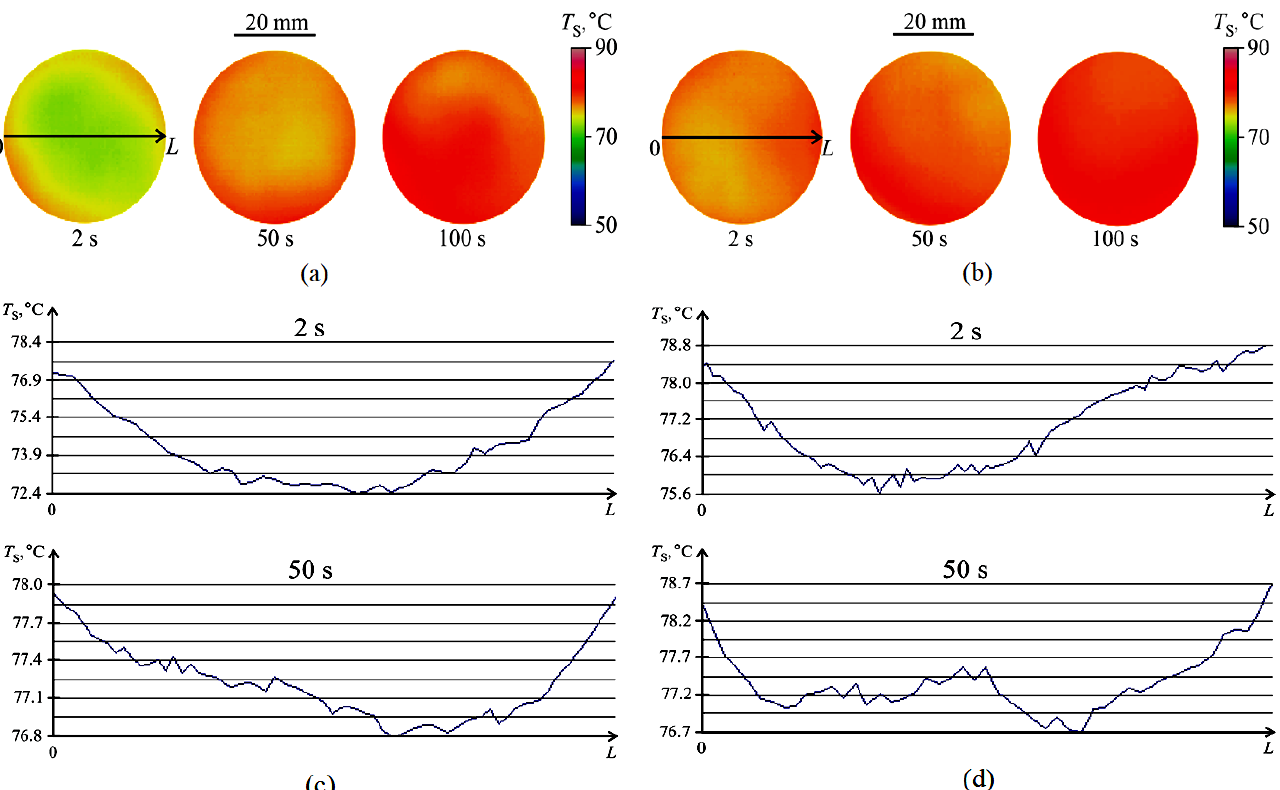
Figure 9. Thermal images of the layer interface of ( a ) pure water and ( b ) the surfactant solution. Temperature profiles of T s along the 0 L line for ( c ) the water layer and ( d ) the surfactant solution layer, ( a – d ) T w = 90 °C, T a = 21 °C.